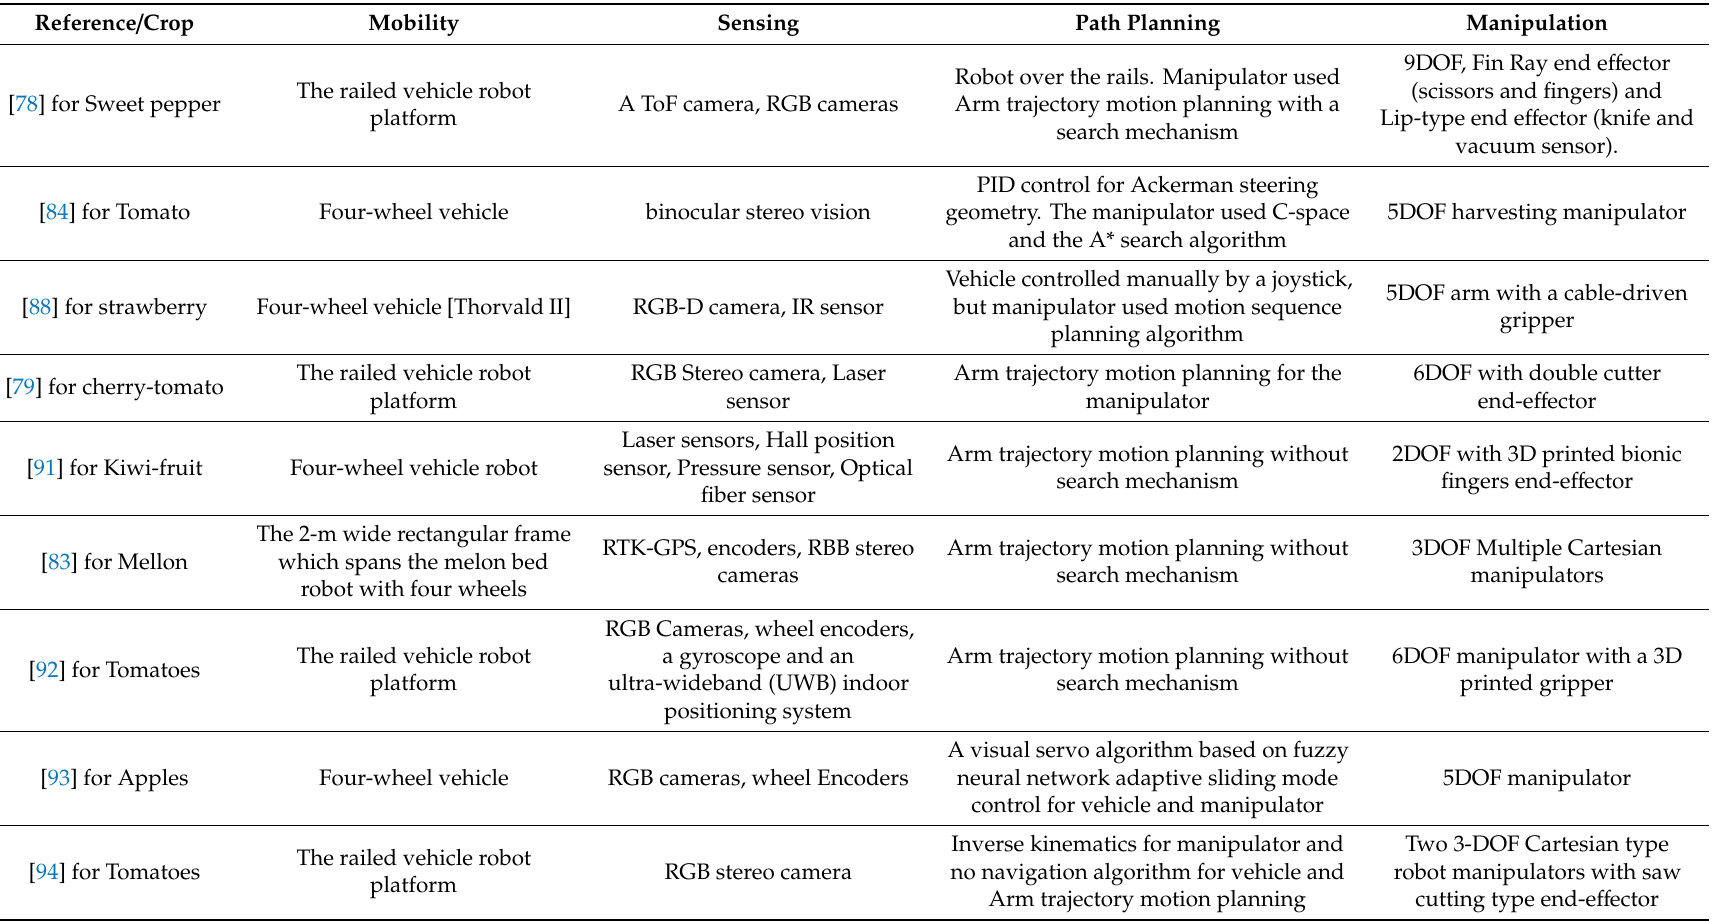
Table 4. Recent robotic systems developed for harvesting agricultural